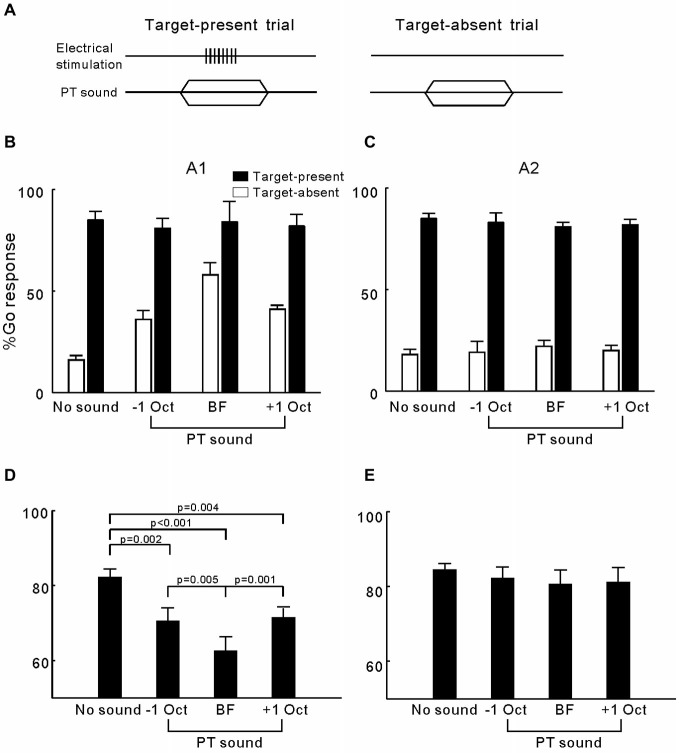
Detection of ICMS presented together with pure-tones. (A) Presenting both ICMS and pure-tone in a target-present trial but only pure-tone in a target-absent trial. (B) Percentage of Go responses in each Go/No-Go task for detection of ICMS in A1. Open and filled bars represent the mean percentage of Go responses in the target- absent and target-present trials, respectively. Error bars represent SE. (C) Percentage Go of responses in each Go/No-Go task for detection of ICMS in A2. (D) Mean and SE for the percentage of correct ICMS detection in A1 when presented together with different frequencies of pure-tones. P values were obtained using ANOVA with a post hoc Student’s t-test. (E) Mean and SE for the percentage of correct ICMS detection in A2.